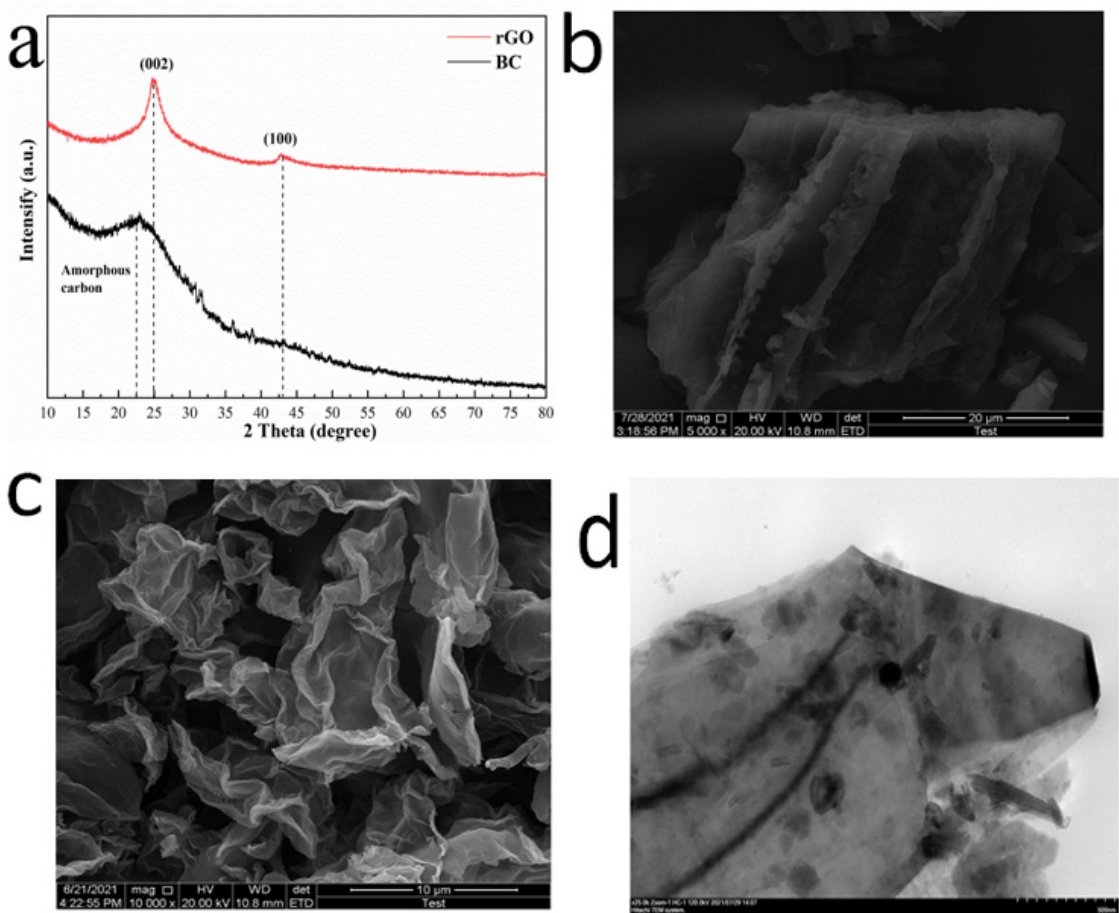
Figure 2. XRD ( a ) of BC and rGO, SEM of BC ( b ) and rGO ( c ), TEM of BC ( d ). 3.2. Hydrogen Desorption Performances of MgH 2 + BC and MgH 2 + rGO